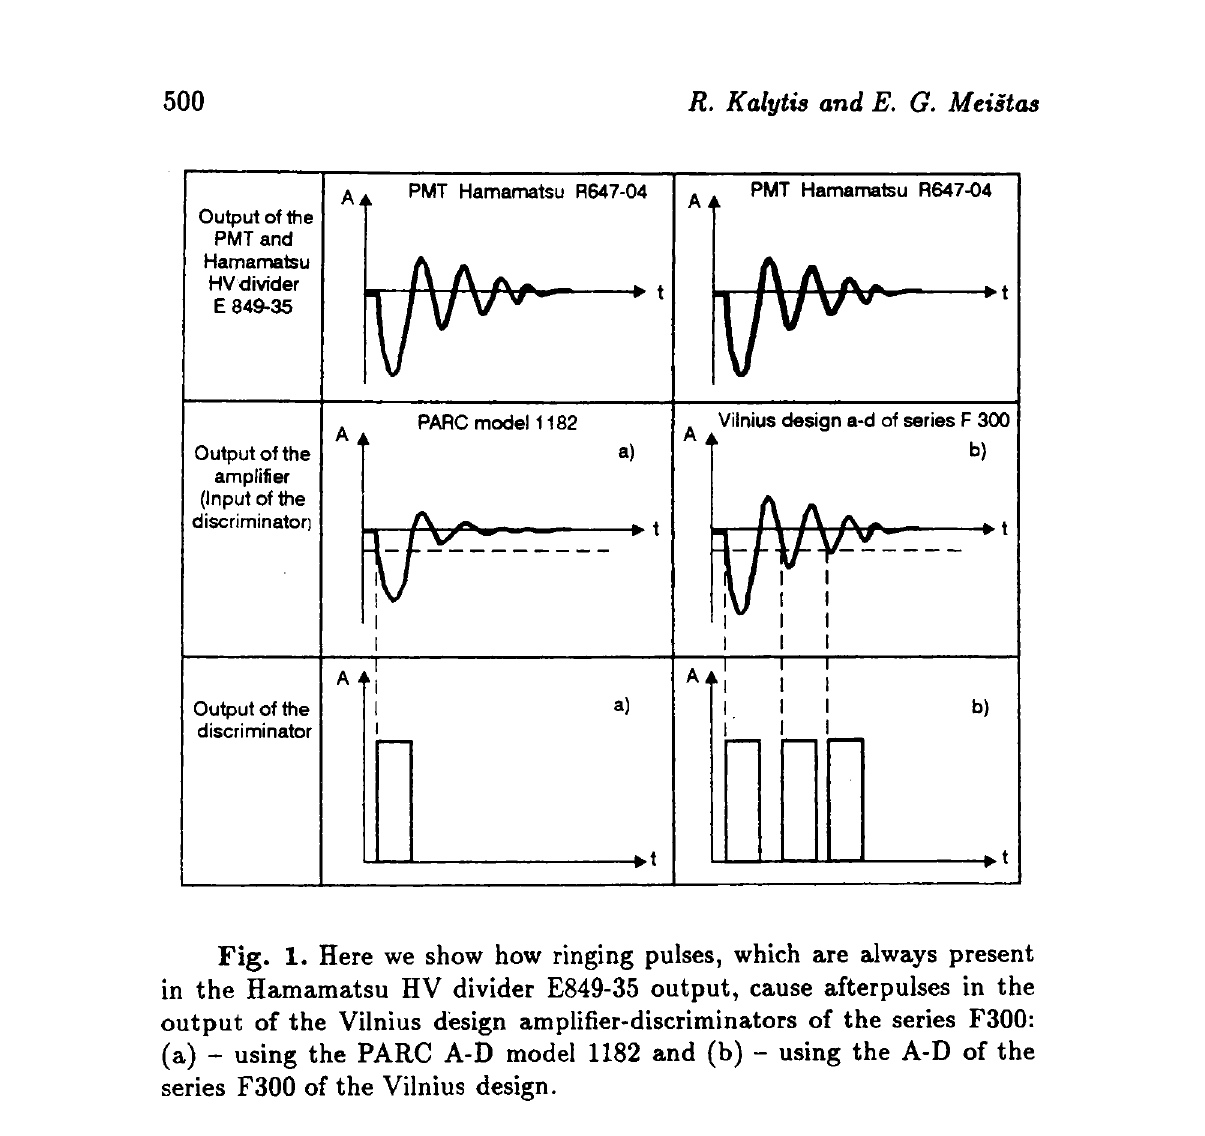
Fig. 1. Here we show how ringing pulses, which are always present in the Hamamatsu HV divider E849-35 output, cause afterpulses in the output of the Vilnius design amplifier-discriminators of the series F300: (a) - using the PARC Α-D model 1182 and (b) - using the Α-D of the series F300 of the Vilnius